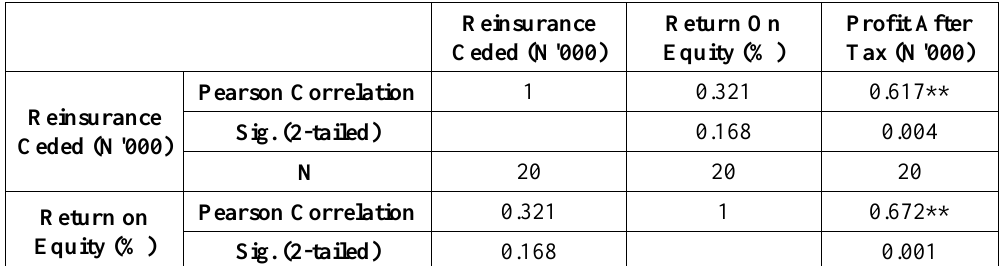
Table 2. Correlation Analysis of Reinsurance Capacity and